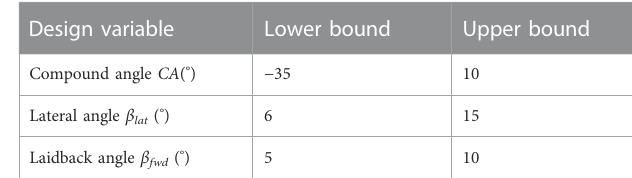
TABLE 2 Design space during the